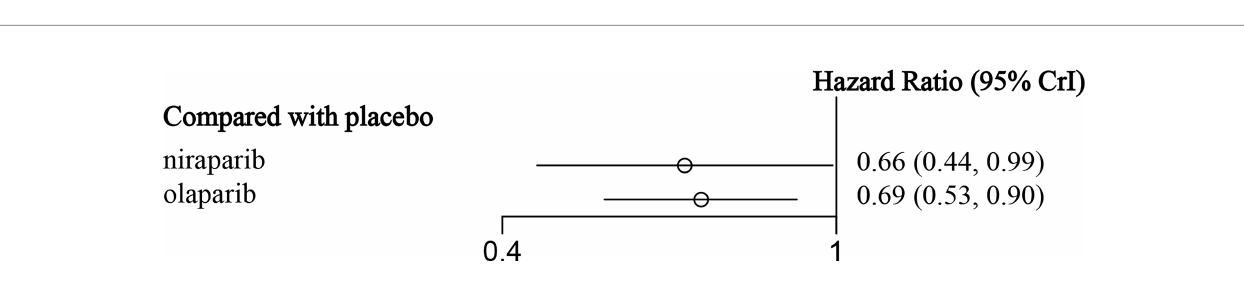
FIGURE 4 | The forest plot of OS in gBRCA-mutated patients.